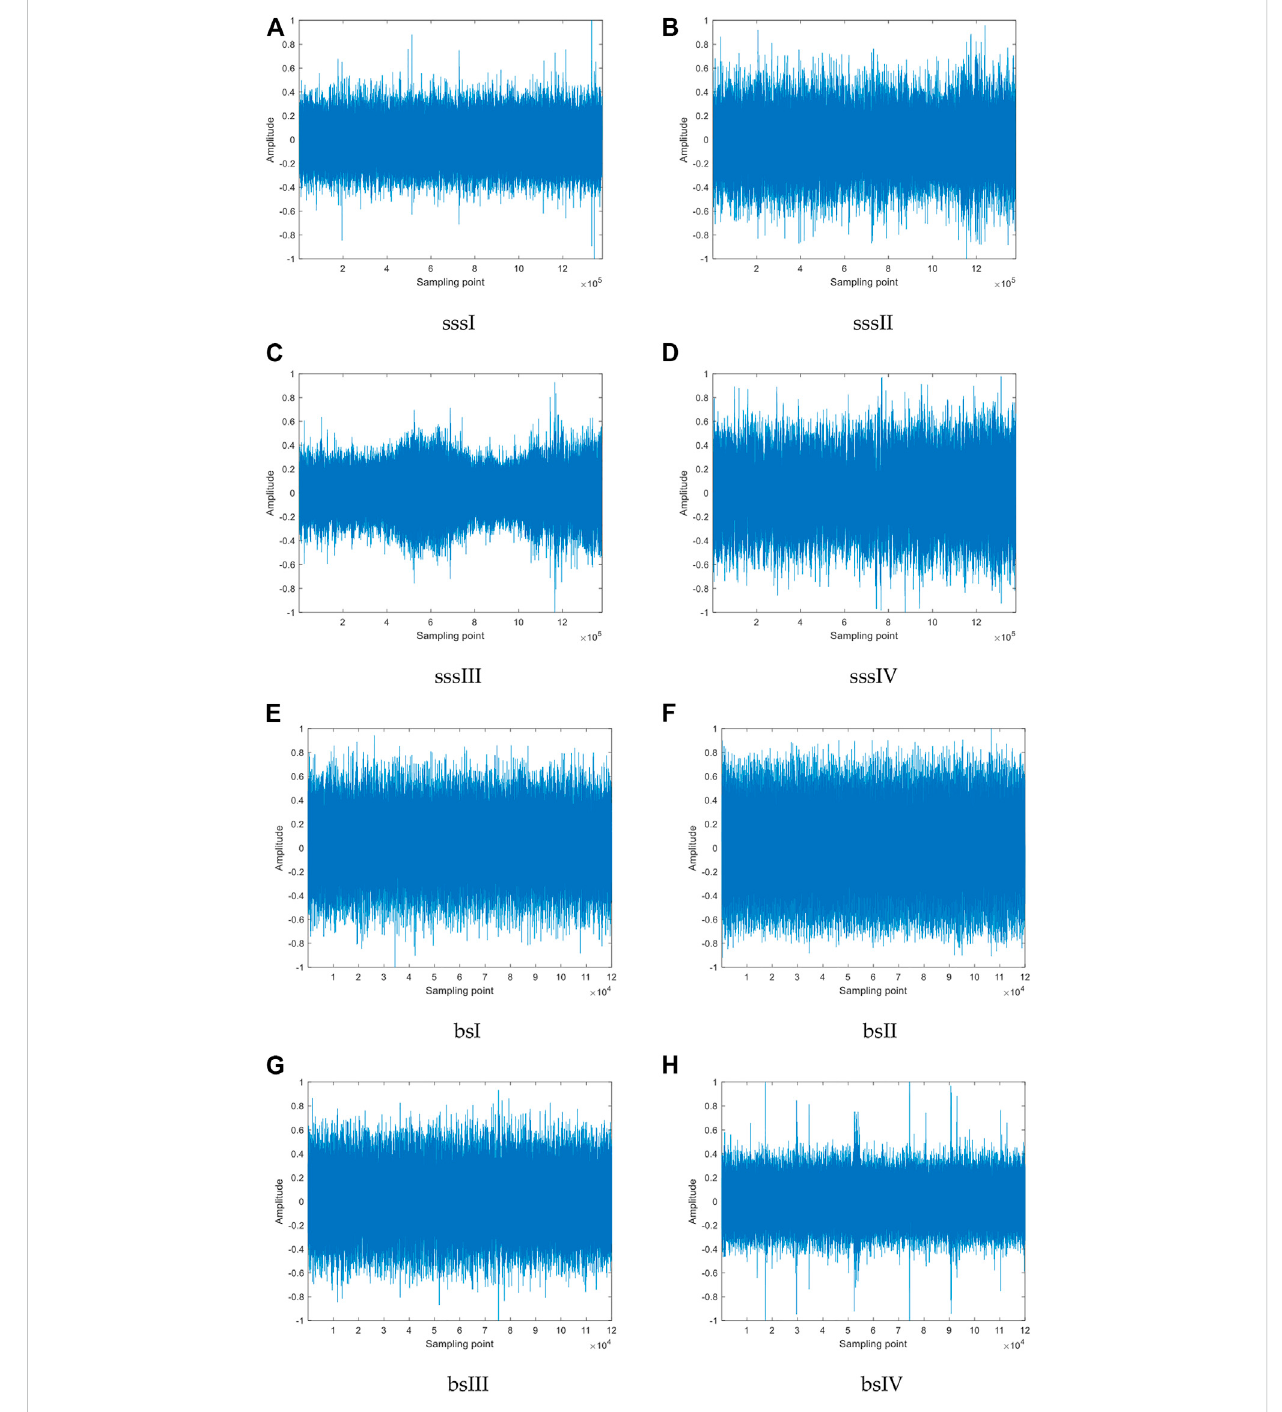
FIGURE 3 Normalized time-domain waveforms of four diverse types of SSSs and BSs: (A) sssI, (B) sssII, (C) sssIII, (D) sssIV, (E) bsI, (F) bsII, (G) bsIII, (H)